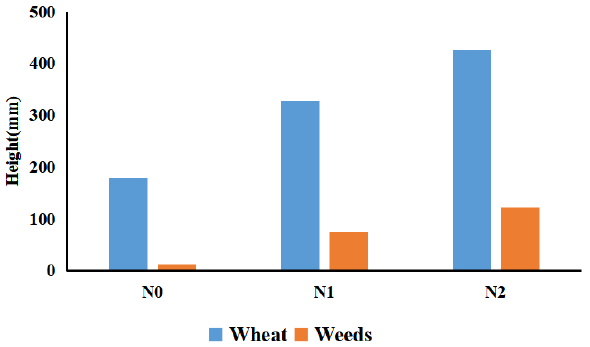
Figure 6. Height information of wheat and weeds under different treatments.